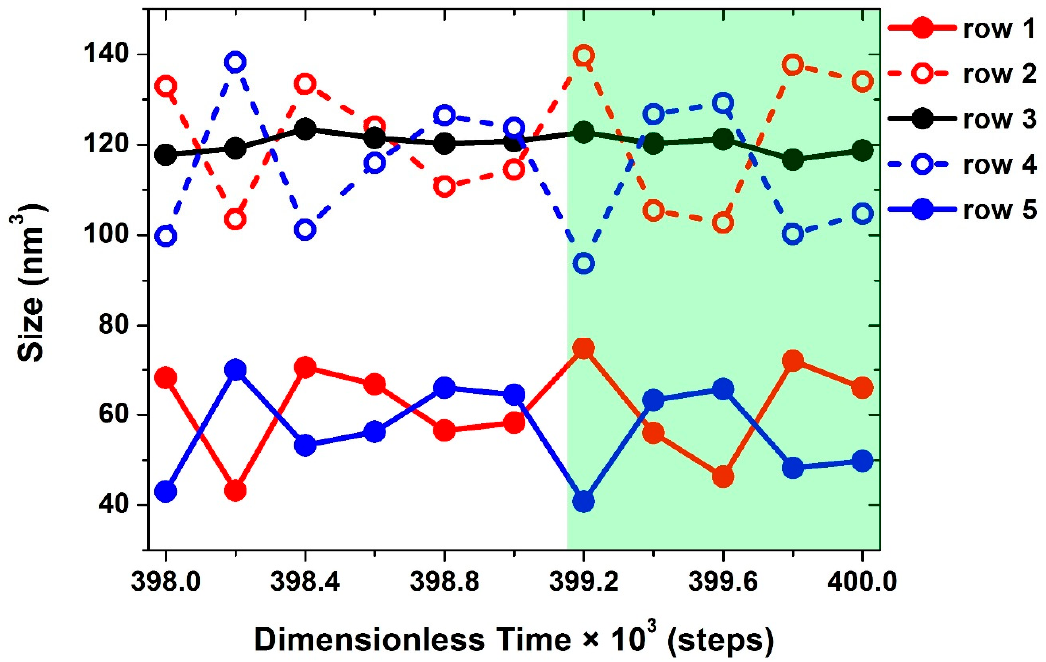
Figure 7. Under YW55 confinement, the average size of the cylinders in each row with the time evolving from 398.0 × 10 3 steps to 400 × 10 3 steps. The green region is selected for the following analysis given in Figure 8.